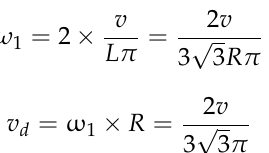
point C to reach the minimum